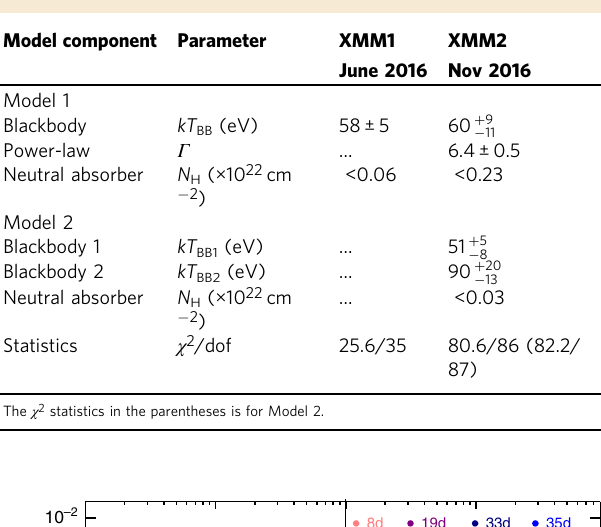
Table 2 Spectral fi tting results for the X-ray data.